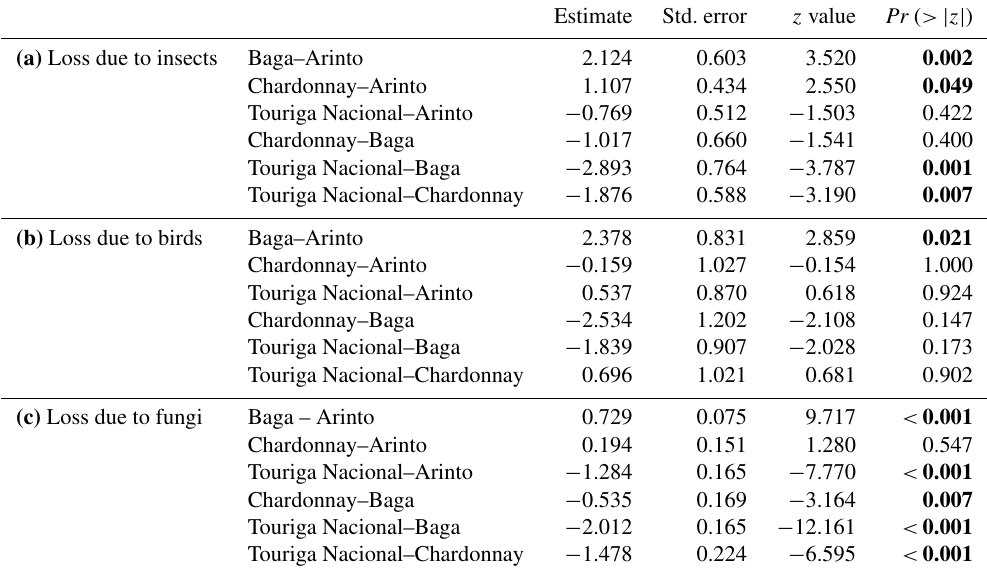
Table 1. Summary of the general linear hypothesis models testing the effect of grape caste and color on fruit loss by insects, birds and fungi. The models compare all caste color pairs. Significant results an α ≤ 0 . 05 are highlighted in